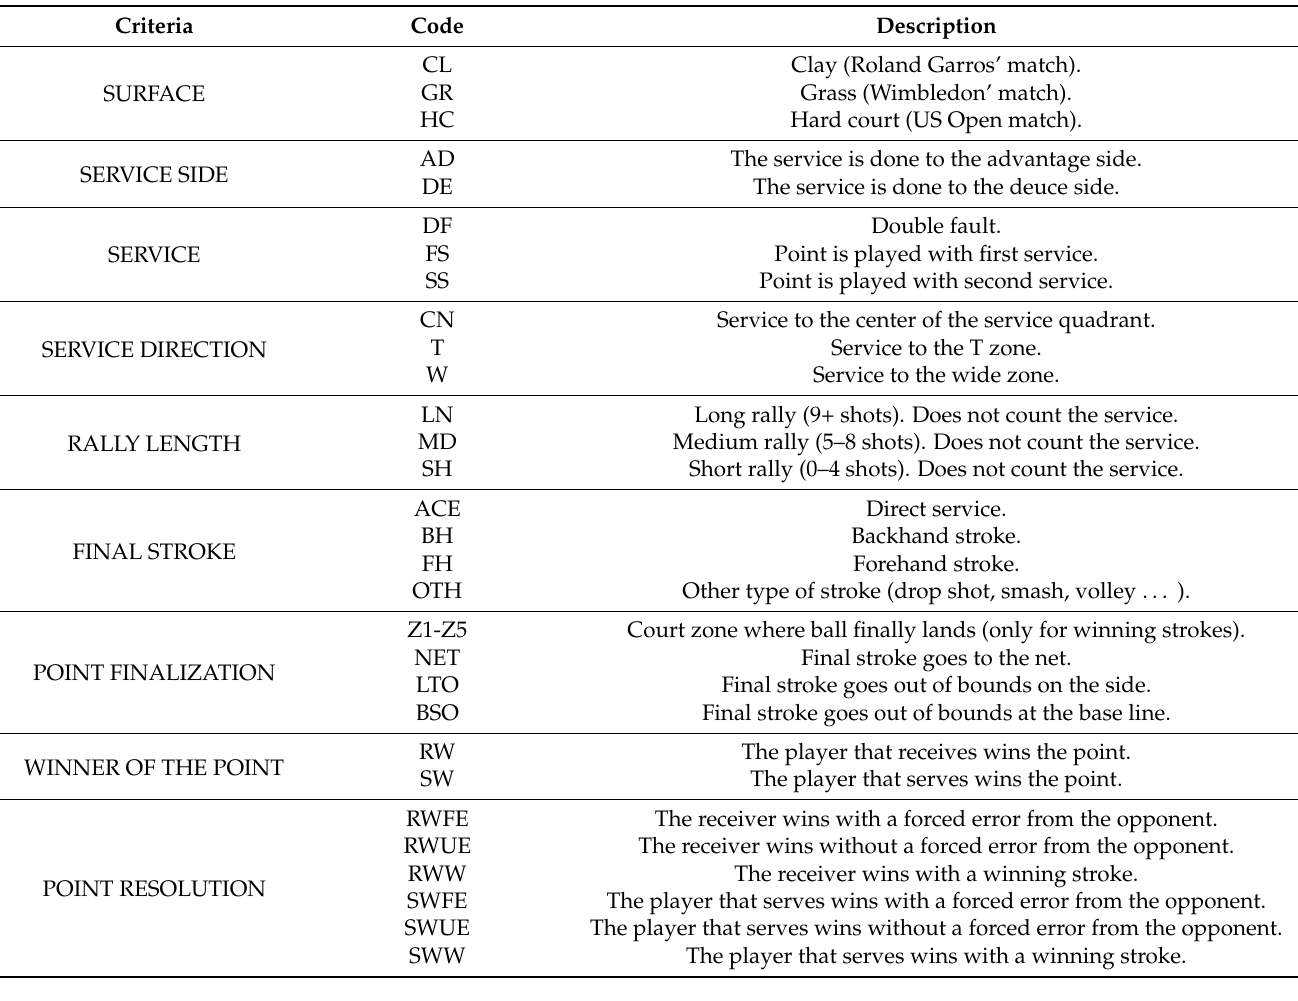
Table 1. Observation instrument OBSTENNIS-v2.